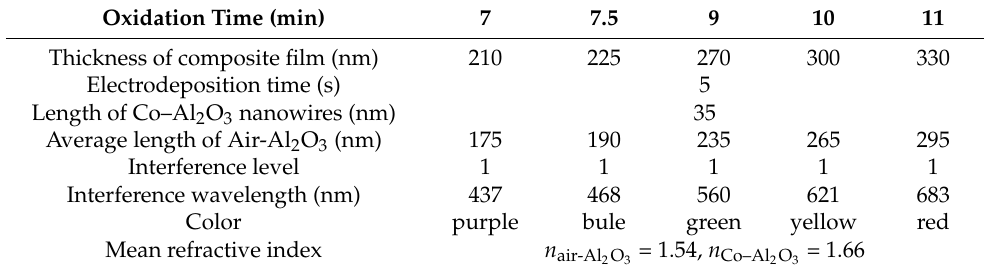
Table 1. The parameters of composite films with different oxidation times shown in Figure